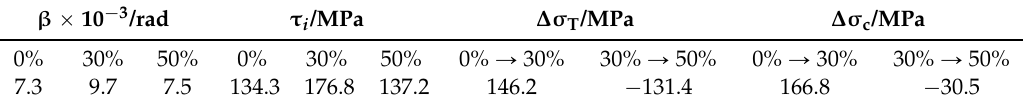
Table 2. Effects of texture and work hardening on the YS of solid solutioned specimen